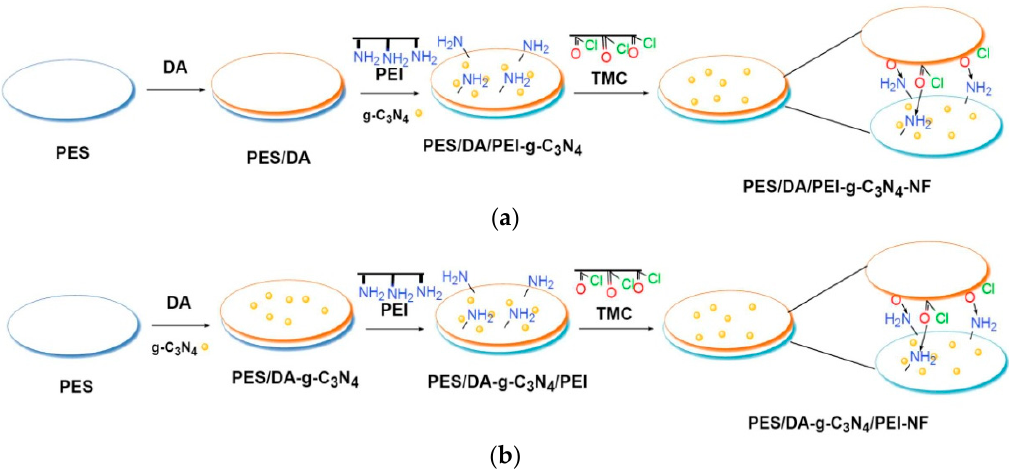
Figure 1. The schematic of preparation of M4 ( a ) and M5 ( b ) NF membranes. Table 1. Preparation conditions of NF